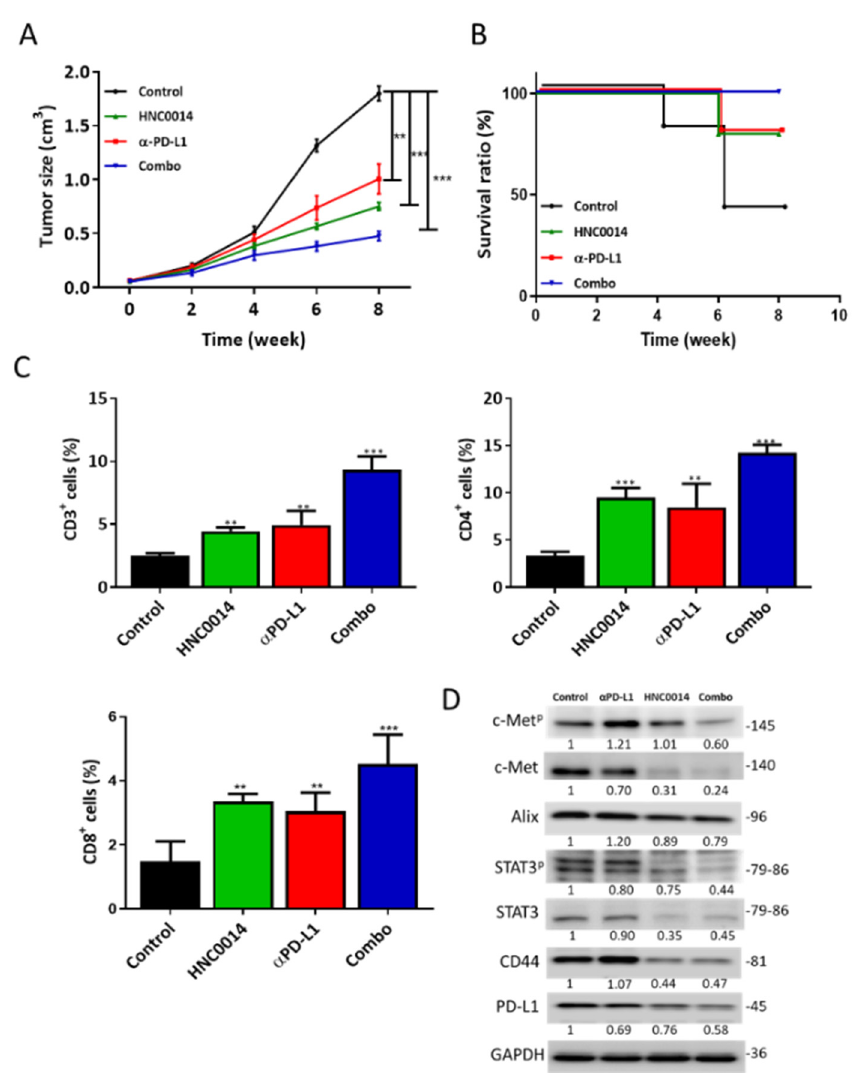
Figure 6. Evaluation of HNC0014 immunotherapeutic functions in syngeneic mouse oral cancer model. ( A ) Tumor volume versus time curve showing slower tumor growth in mice treated with HNC0014 alone, α PD-L1 antibody alone, and the combination of HNC0014 and PD-L1 antibody ( α PD-L1), compared to vehicle control. ( B ) Kaplan–Meier survival curve depicting the highest survival ratio of mice in the combined treatment group (HNC0014 + α PD-L1) over the individual treatments, while the control group showed the lowest survival ratio. ( C ) Comparative blood T cell profiles. Flow cytometric results of the blood samples from each group demonstrated significantly higher percentages of CD3 + (total T cells), CD4 + (helper T cells), and CD8 + (cytotoxic T cells) cell populations in all treatment groups, compared to the control counterparts. ** p < 0.01, *** p < 0.001. ( D ) Western blots of serum exosomes isolated from each group. A markedly reduced expression of c-Met, STAT3, PD-L1, CD44, and the phosphorylated forms of c-Met and STAT3 (c-Met p and STAT3 p respectively) in the HNC0014-alone and combination groups were observed compared to the control counterparts. Alix served as an exosomal marker.